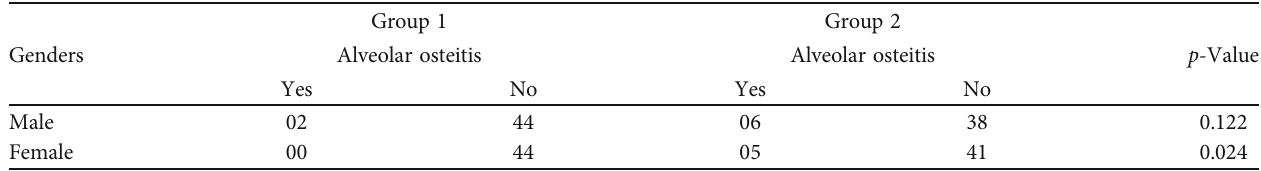
T ABLE 5: Strati fi cation of alveolar osteitis with respect to